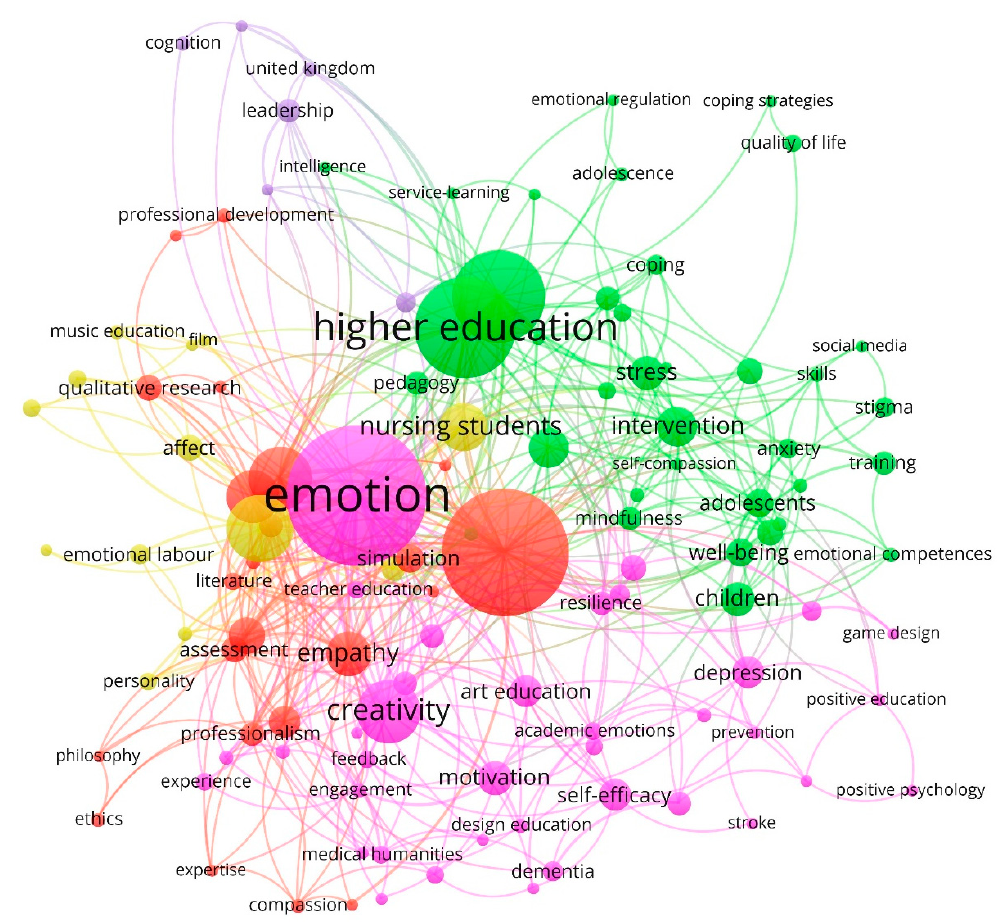
Figure 6. Network of keywords based on the co-occurrence method (1917–2020).